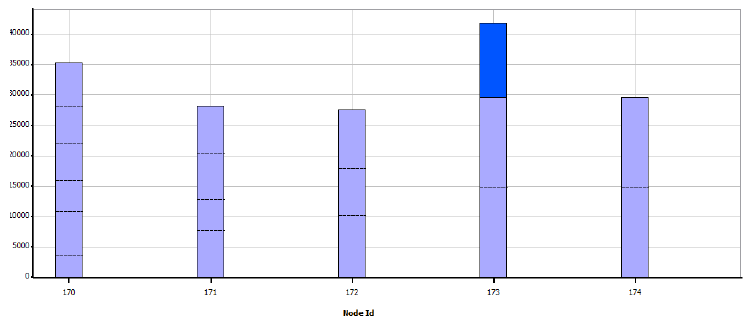
Figure 10. Total data (bytes) received per node—WiFi.